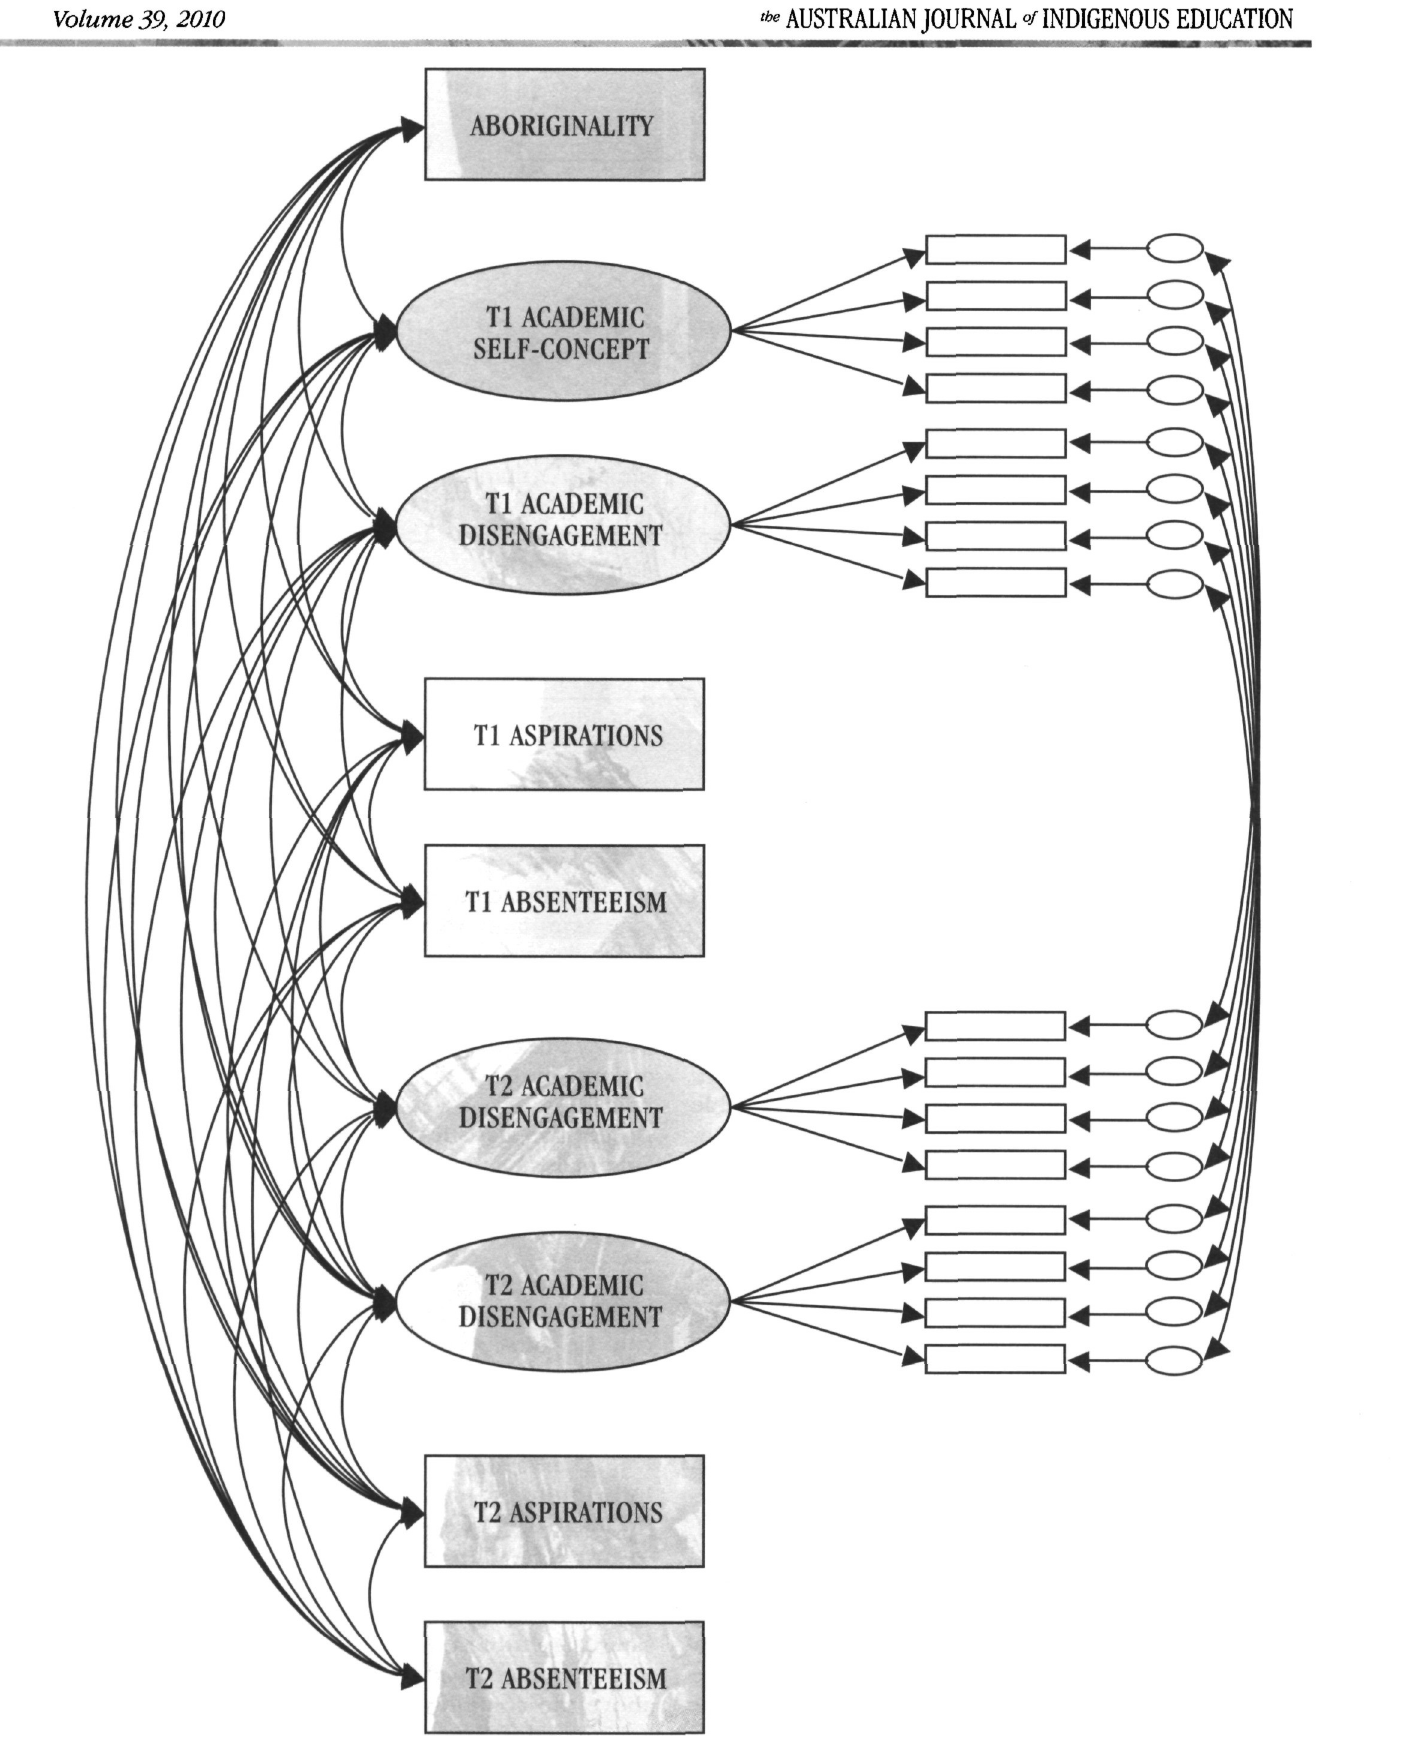
Figure 1. Factor structure for the total sample CFA. Note: Aboriginality = 1 Indigenous - 2 non-Indigenous; Tl = Time 1 measures; T2 = Time 2